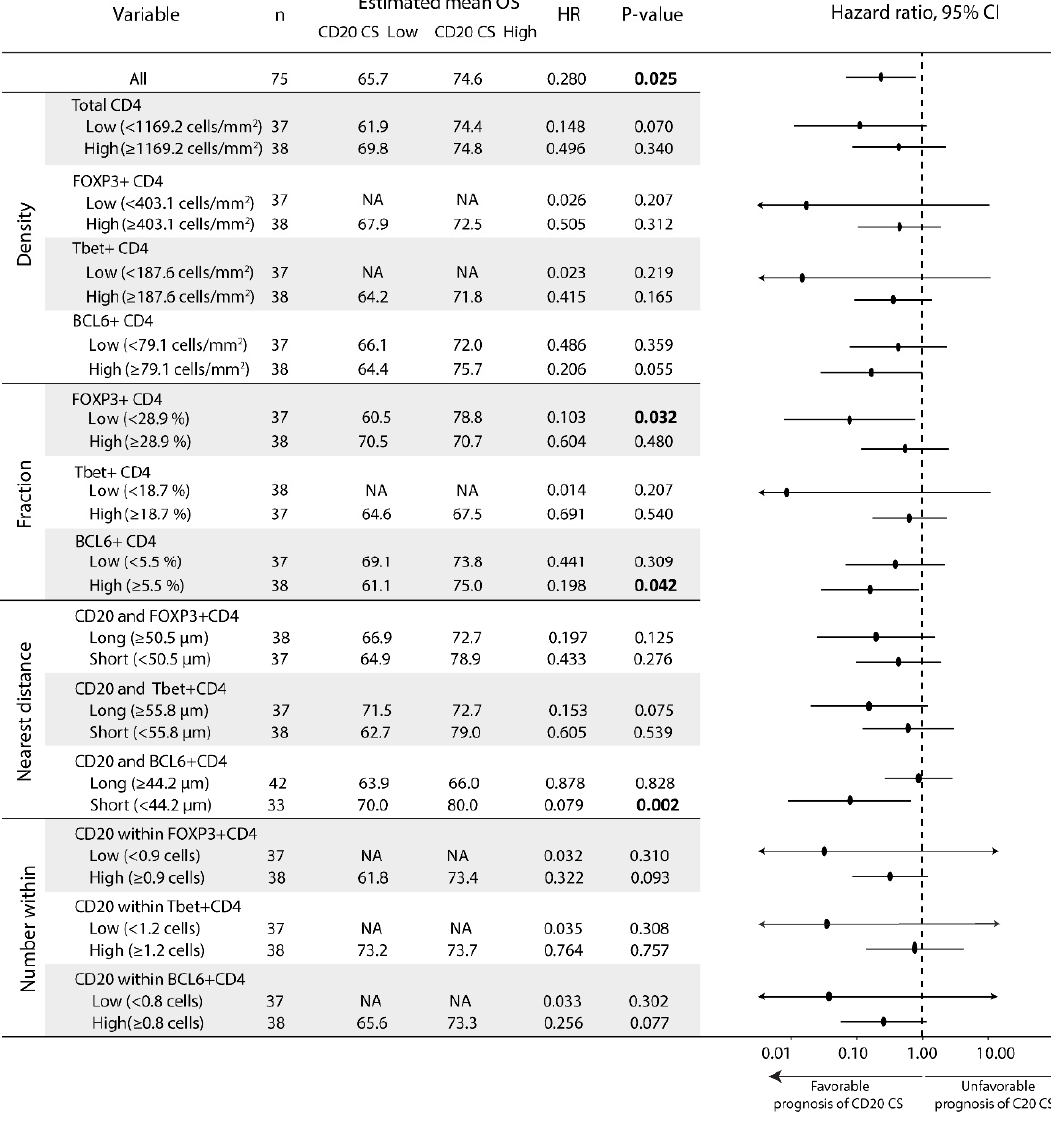
Figure 4. The prognostic value of the CD20 cluster score is impacted by a low fraction of Treg cells, a high fraction of Tfh cells, and a short distance between CD20 B and Tfh cells. Forest plot of subgroup analysis for the CD20 cluster score according to density and fraction of CD4 T cell subsets, as well as nearest distances to and numbers within 20 µ m from B cells of CD4 T cell subsets. The estimated mean overall survival, HR, 95% CI, and p -value are shown for each variable; in the case of p -value < 0.05, this is highlighted in bold. Abbreviations: CD20 CS, CD20 cluster score; HR, hazard ratio; NA,